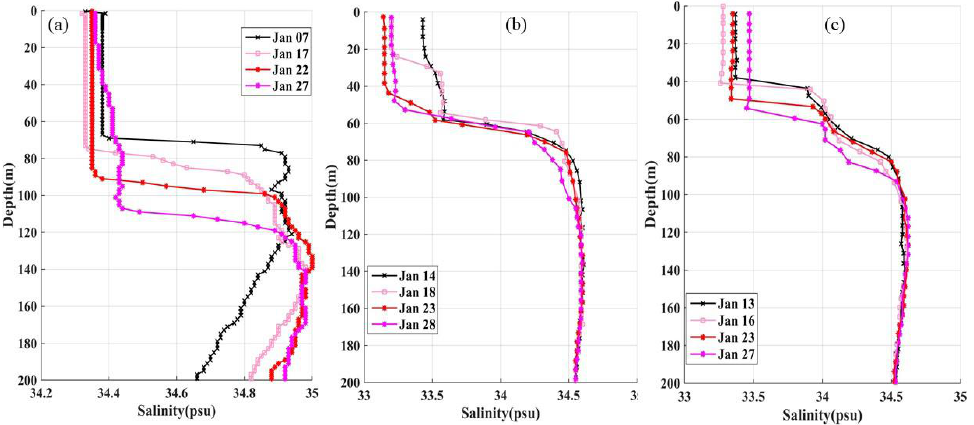
Figure 13. Vertical profiles of salinity at three Argo stations (a) 2902753, (b) 2902784, and (c) 2902786 around the time of the eruption of the Taal volcano.